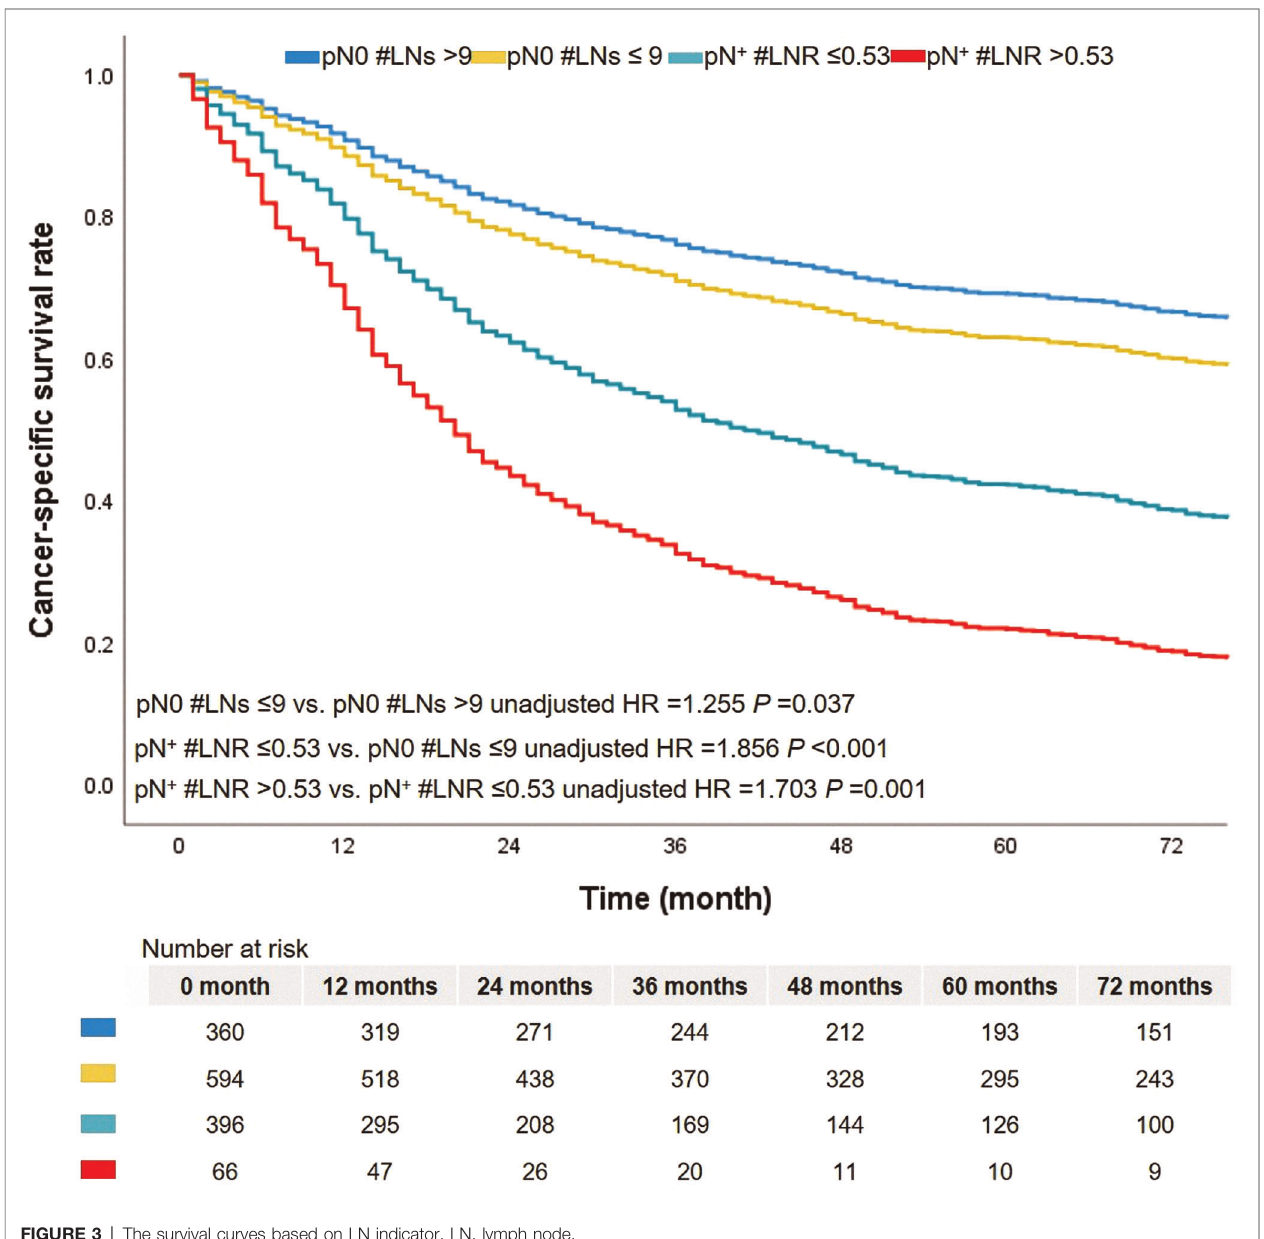
FIGURE 3 | The survival curves based on LN indicator. LN, lymph